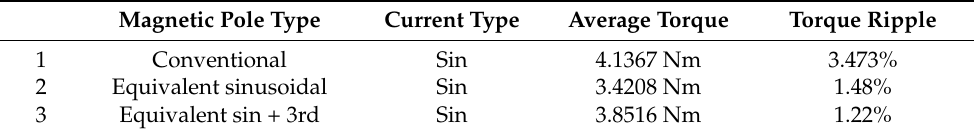
Table 8. Performance comparison of dual three-phase PMSM with the same current